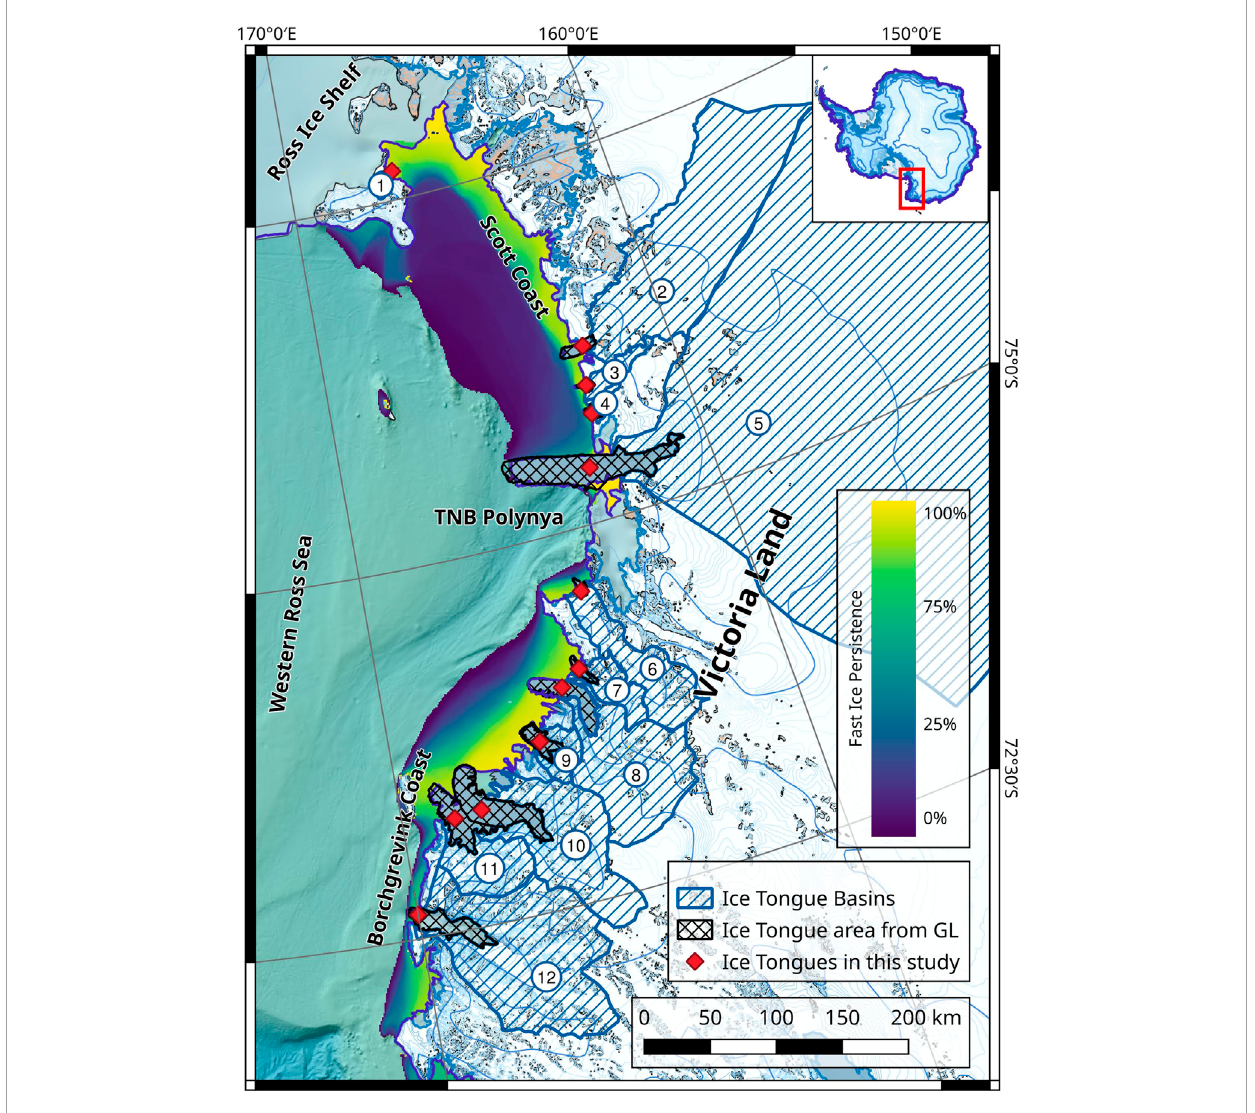
FIGURE 1 Red diamonds indicate the Ice tongues included in this study, their areas from the grounding line are cross-hatched in black. Numbers indicate the ice tongues and basins as they are shown in tables and figures in this article. The catchment areas of the different ice tongues are shown in hatched blue. The percentage of sea ice persistence in the areas surrounding the ice tongues over the 2000–2018 period was averaged from Fraser et al. (2021) data. Yellow indicates areas with year-round land-fast sea ice, and blue areas with sporadic land-fast sea